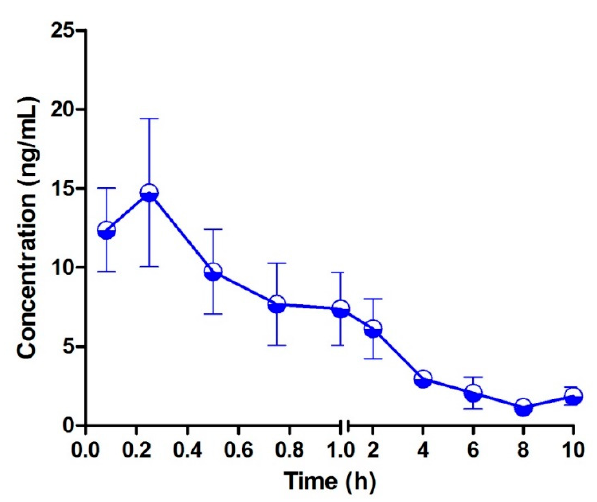
Figure 5. Mean plasma concentration–time profiles of bufalin in rats after oral administration of 10 mg/kg ( n = 3).